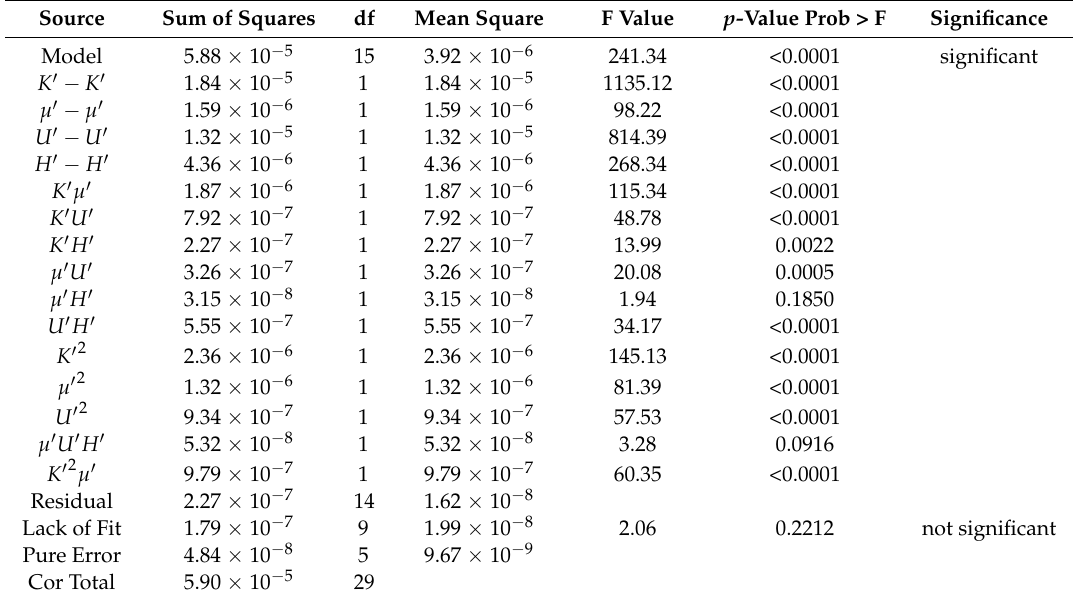
Table 4. Analysis of variance (ANOVA).